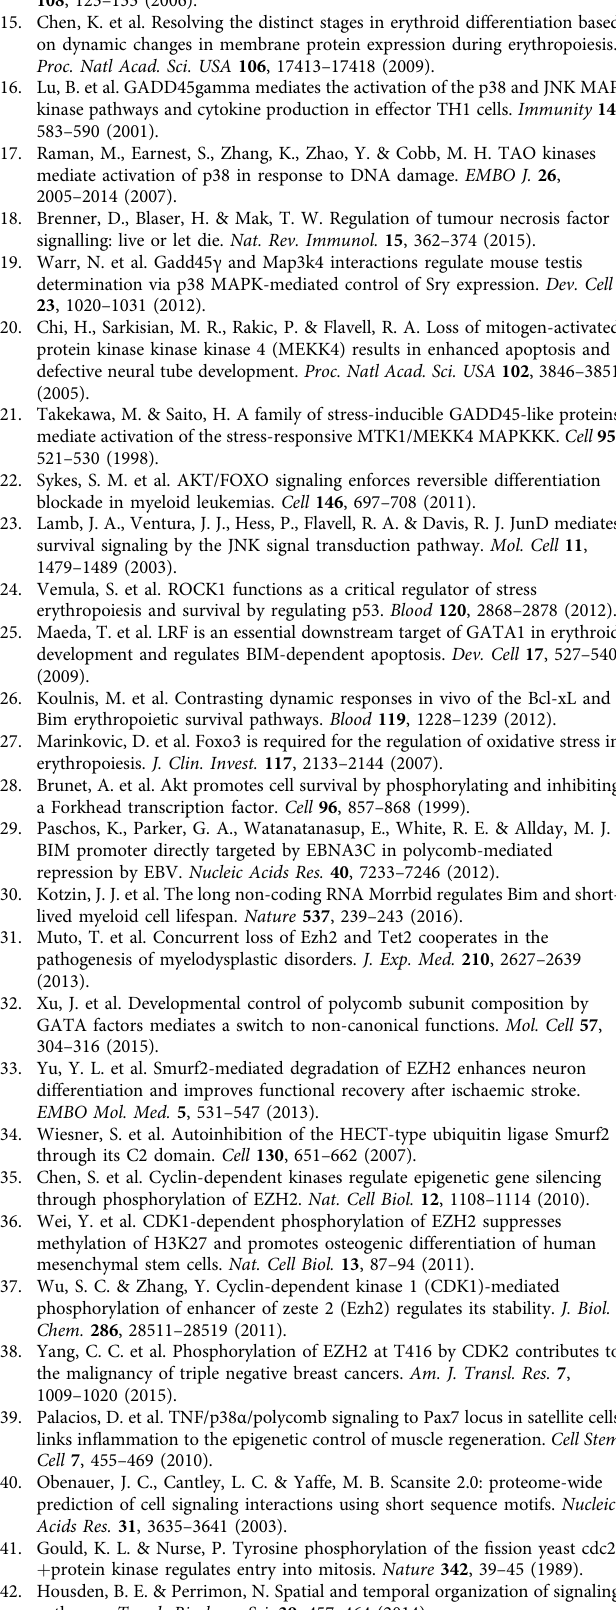
table 3. The antibodies used for CHIP experiments are anti-H3K27me3 (07-449, Millipore,1:500), anti-Ezh2 (5246, Cell Signaling,